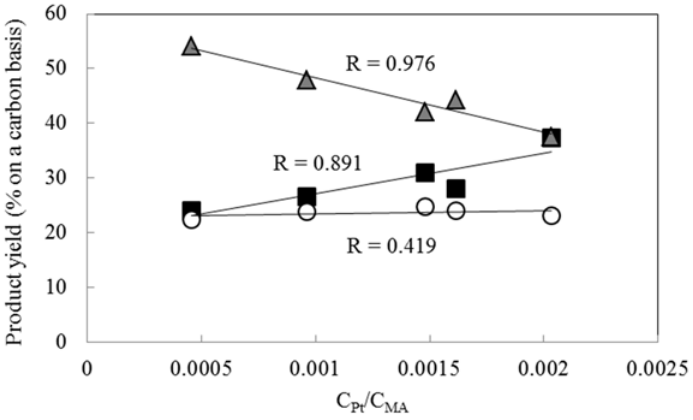
Figure 4. Effect of C Pt / C MA on the hydrocracking reaction over Pt-loaded BEA28